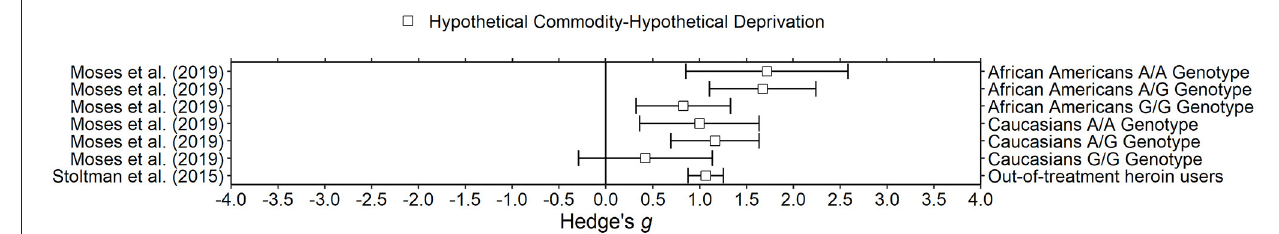
FIGURE 4 | Effect sizes for opioid deprivation experiments. Effect size is Hedge’s g . Points closer to 0 indicate smaller effect sizes. Points to the right of the line indicate increases in delay discounting due to deprivation, the predicted effect. Subjects discounted hypothetical outcomes and experienced hypothetical